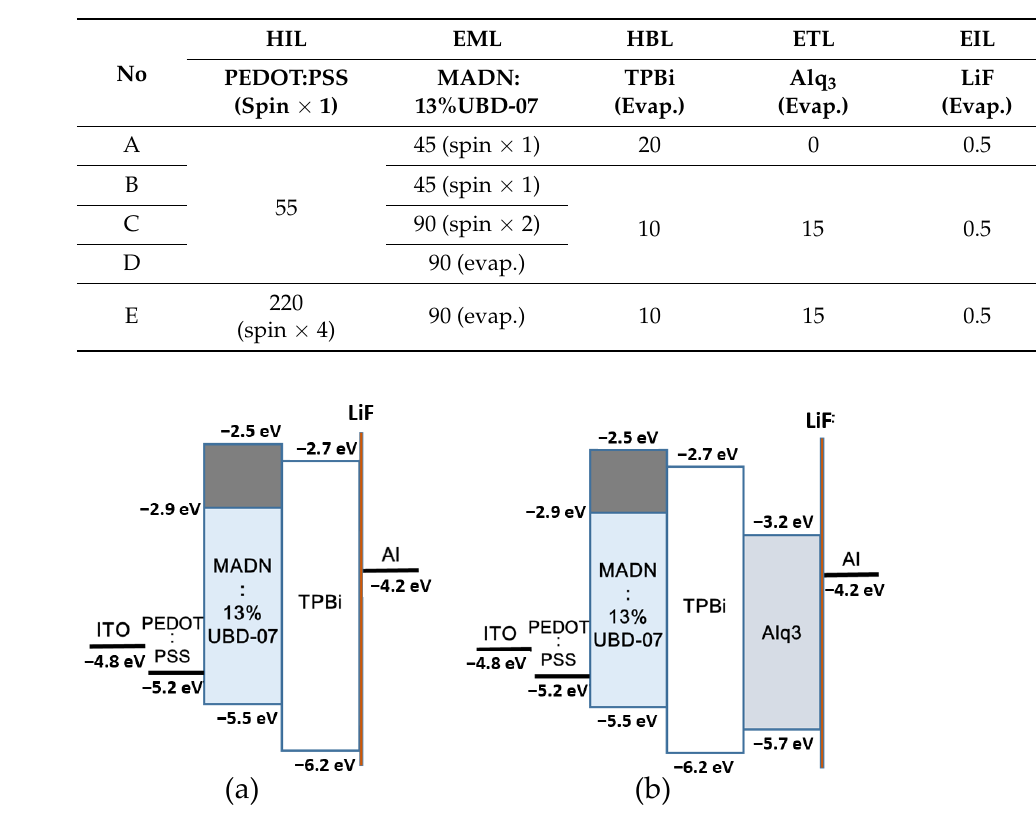
Table 1. Device structure parameters (unit: nm).